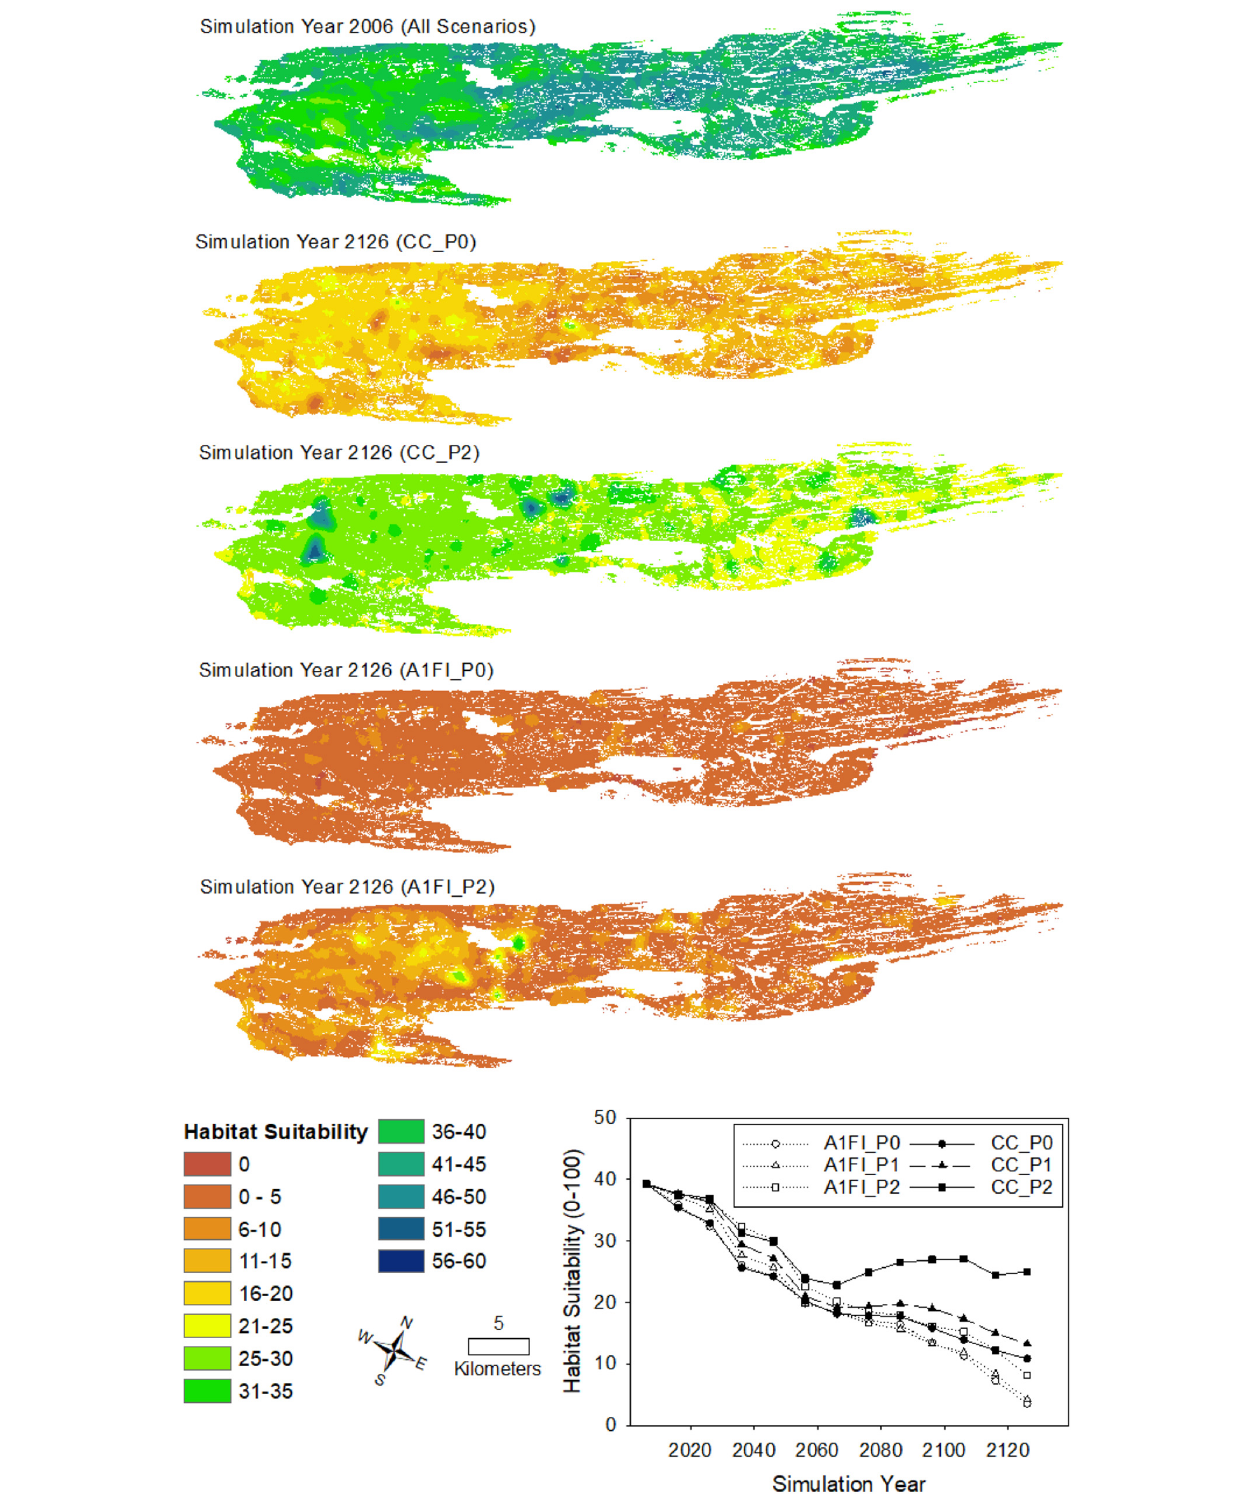
FIGURE 3 | Mapped distributions of habitat suitability for moose based on forage quantity and quality for initial model conditions (simulation year 2006) and after 120 years of current climate and no predation (CC_P0), current climate and strong predation (CC_P2), high emissions and no predation (A1FI_P0), and high emissions and strong predation (A1FI_P2). Inset graph shows the mean habitat suitability for each 10 years for all scenarios (CC_P1 is current climate with weak predation, A1FI_P1 is high emissions with weak predation).